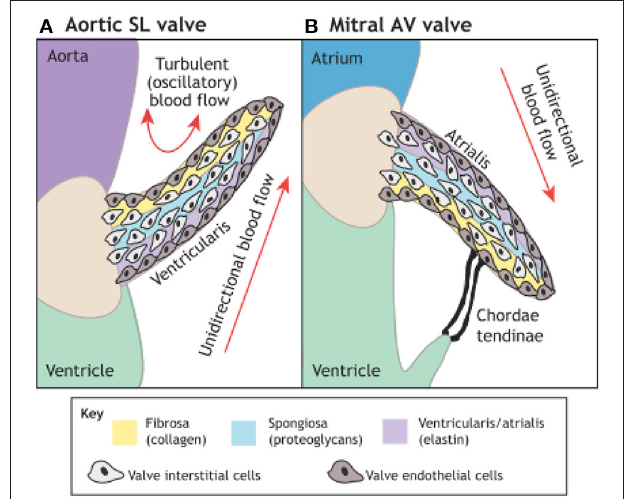
FIGURE 12 | The microarchitecture of adult cardiac valves (A,B) . The stratified structure of aortic (A) and mitral (B) cardiac valves ensures unidirectional blood flow. Valve leaflets are composed of three layers of stratified extracellular matrix, including an elastin-rich ventricularis layer in the SL valves or the atrialis layer in the AV valves (purple), a proteoglycan-rich spongiosa layer (light blue) and a collagen-rich fibrosa layer (yellow), interspersed with valve interstitial cells (VICs) and sheathed in a monolayer of valve endothelial cells (VECs). The direction of pulsatile blood flow in relation to valve leaflets is indicated (red arrows). The microarchitecture of an aortic valve leaflet ensures blood moves from the ventricle to the aorta. The microarchitecture of a mitral valve leaflet is supported by the chordae tendineae, which ensure blood flow from the atrium to the ventricle. AV, atrioventricular; SL, semilunar ( 106).